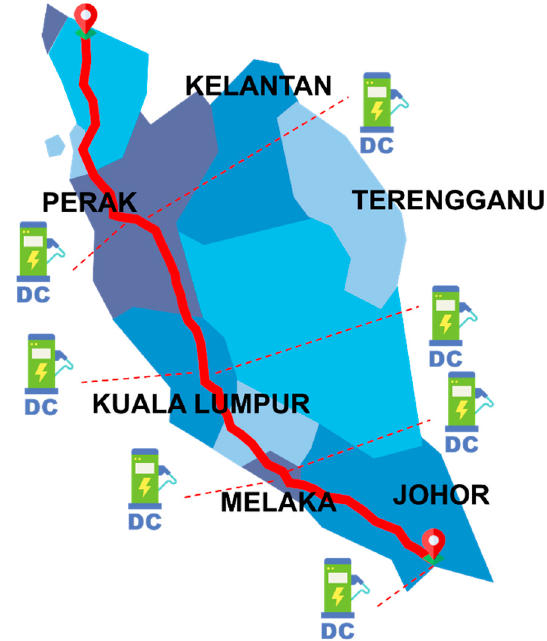
Figure 4. Current and upcoming locations of DC charger along the North–South Expressway by EV Connection Sdn Bhd [29]. Courtesy of Malaysian Green Technology and Climate Change Centre.